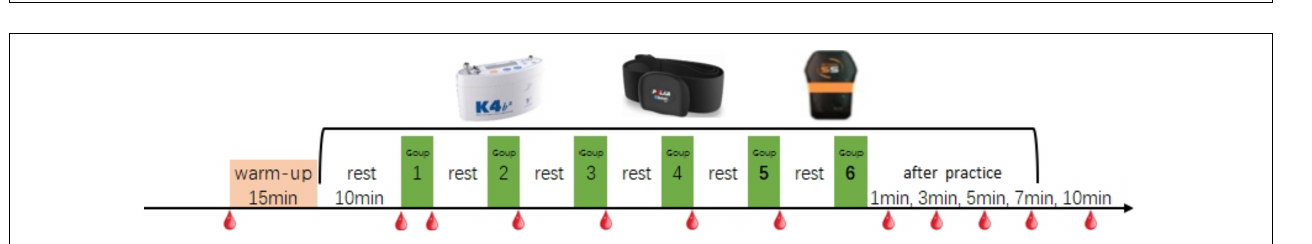
FIGURE 1 | Test flow chart of a badminton match.